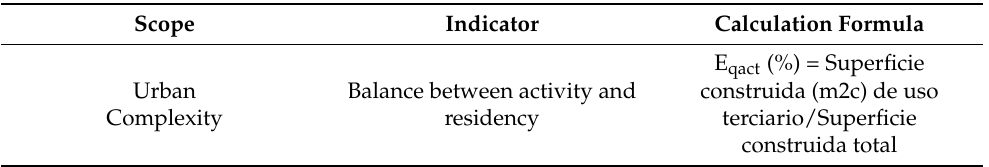
Table 6. Indicator used in the Urban Complexity